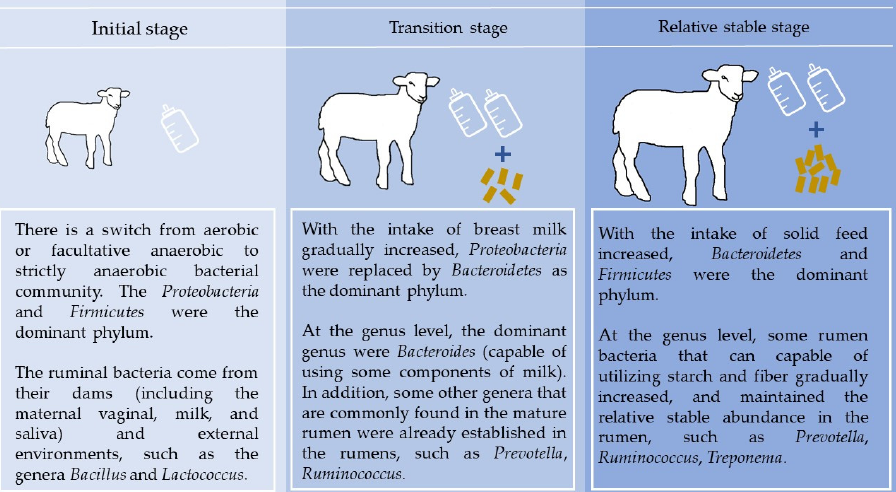
Figure 1. Establishment of rumen bacteria in per-weaned ruminants.